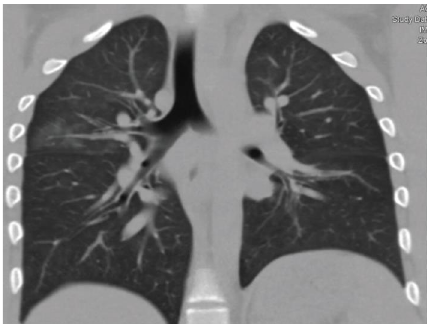
Figure 3: Post-extubation coronal view of CT chest scan showing the resolution of ground-glass opacities following diuretic